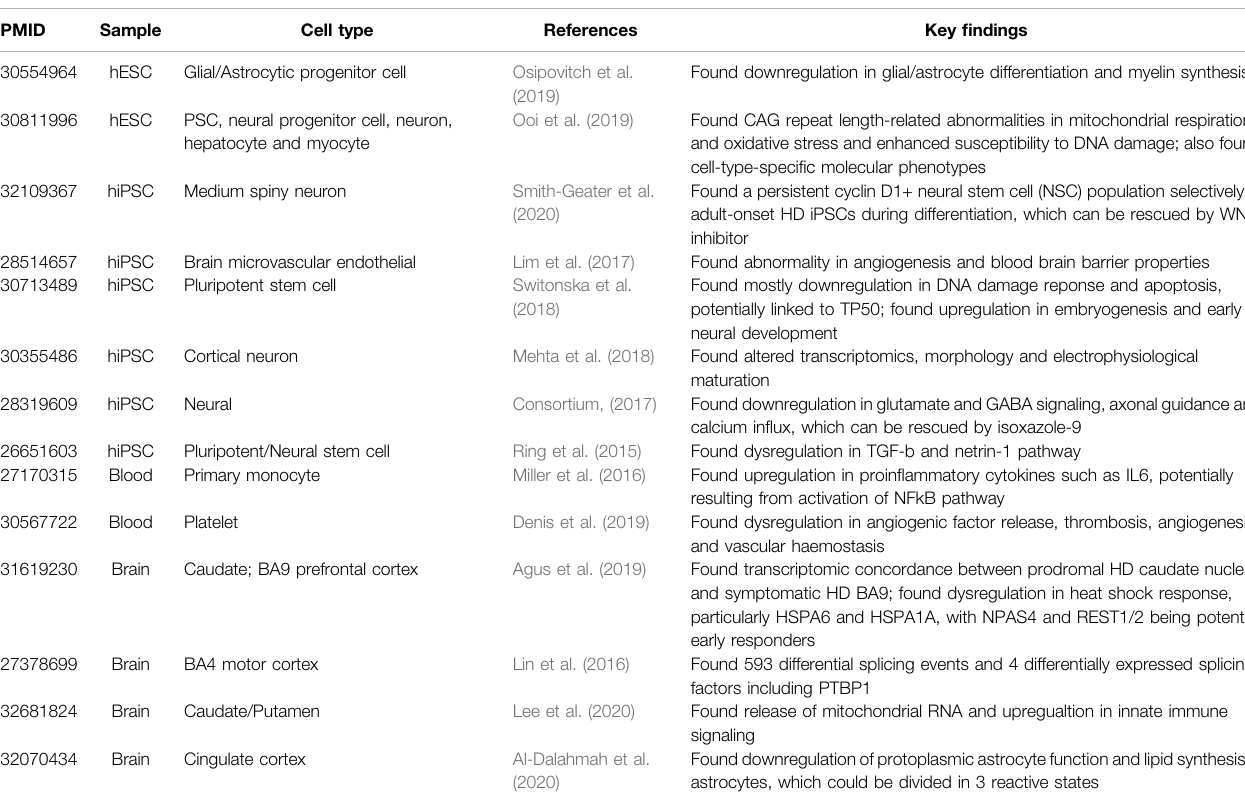
TABLE 1| Characteristics ofhuman HDstudies included in thisreview. The table summarizesPMID, Sample, Cell Type,Reference and Key Findingsofeach includedstudy (Ring et al., 2015; Lin et al., 2016; Miller et al., 2016; Consortium, 2017; Lim et al., 2017; Mehta et al., 2018; Switonska et al., 2018; Agus et al., 2019; Denis et al., 2019; Ooi et al., 2019; Osipovitch et al., 2019; Al-Dalahmah et al., 2020; Lee et al., 2020; Smith-Geater et al.,